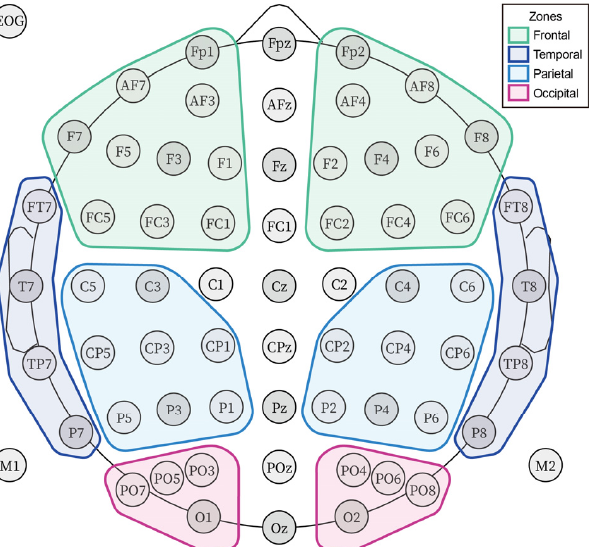
Figure 3. Grouping map of the scalp within the electrodes. The scalp zones were divided as follows. The left frontal zone: FP1, AF3, AF7, F1, F3, F5, F7, FC1, FC3, FC5. The right frontal zone: FP2, AF4, AF8, F2, F4, F6, F8, FC2, FC4, FC6. The left temporal zone: FT7, T7, TP7, P7. The right temporal zone: FT8, T8, TP8, P8. The left parietal zone: C3, C5, CP1, CP3, CP5, P1, P3, P5. The right parietal zone: C4, C6, CP2, CP4, CP6, P2, P4, P6. The left occipital zone: PO3, PO5, PO7, O1. The right occipital zone: PO4, PO6, PO8, O2.